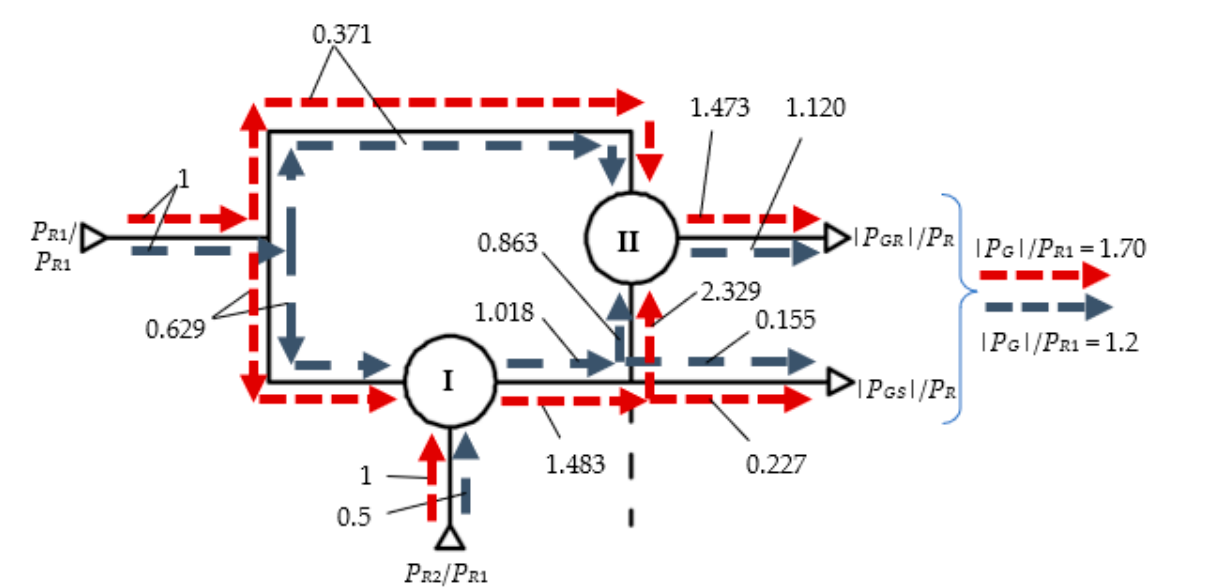
= 0.5 k (blue) and 1